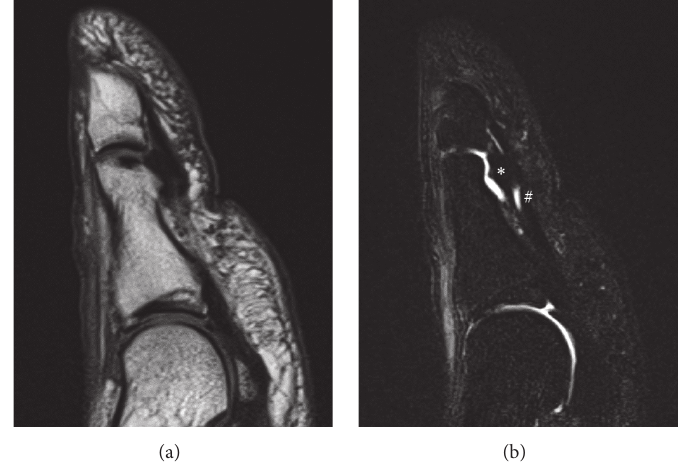
Figure 2: Sagittal T1 and T2 weighted magnetic resonance (MR) images showed a nodule in the plantar capsule at the interphalangeal joint of the great toe and fluid retention around it and the flexor hallucis longus tendon. (a) T1 weighted MR image. (b) T2 weighted MR image. ∗ Plantar capsule nodule. # Flexor hallucis longus.